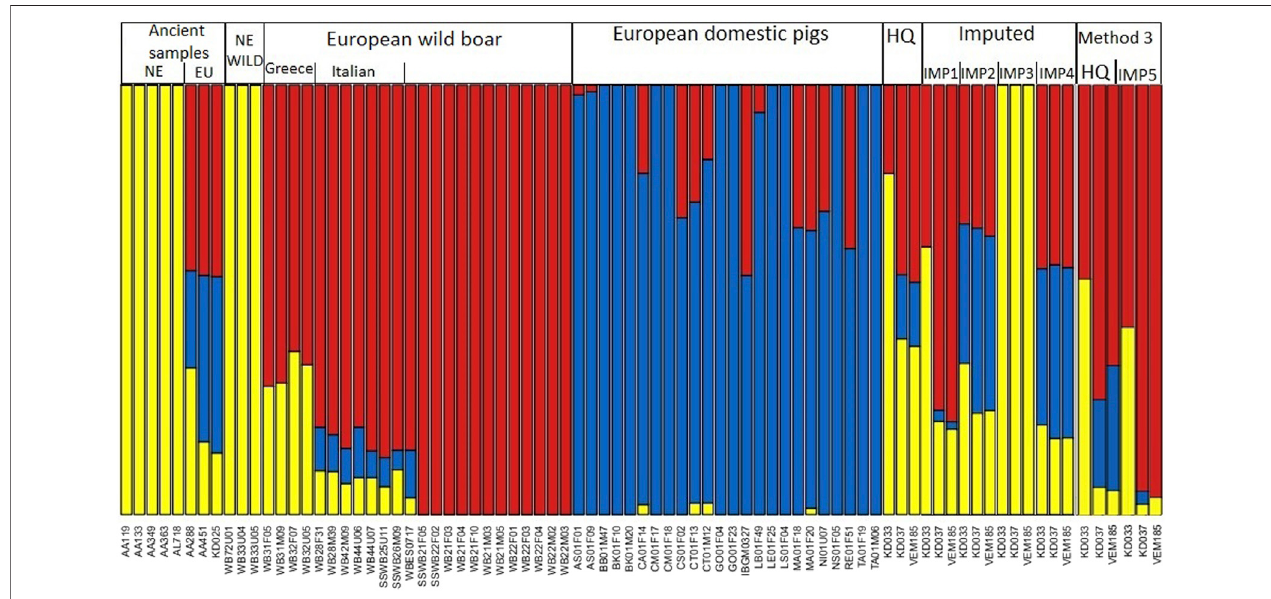
FIGURE 3 | Admixture analysis with K = 3, comparing high-quality and imputed data from IMP1-5 together with samples from the reference panel. NE, Near East; EU, European. The colors represent the three ancestral groups, where blue is European domestic pig, red is European wild boar, and yellow is Near Eastern.